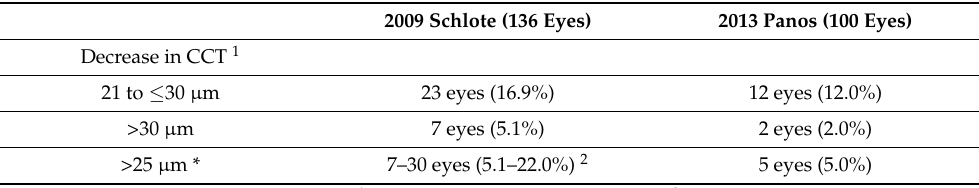
Table 2. Frequency of severe events after 12 months of PGA medication in two studies reporting severe